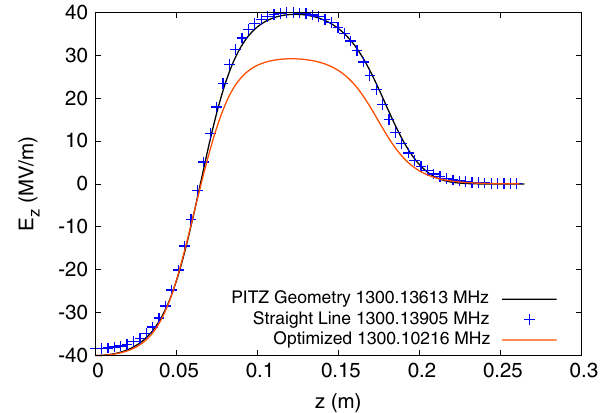
FIG. 21. PITZ on-axis balanced field profiles for the PITZ curvilinear geometry (black) and model straight line geometry (blue crosses). The optimized straight line geometry (red) is